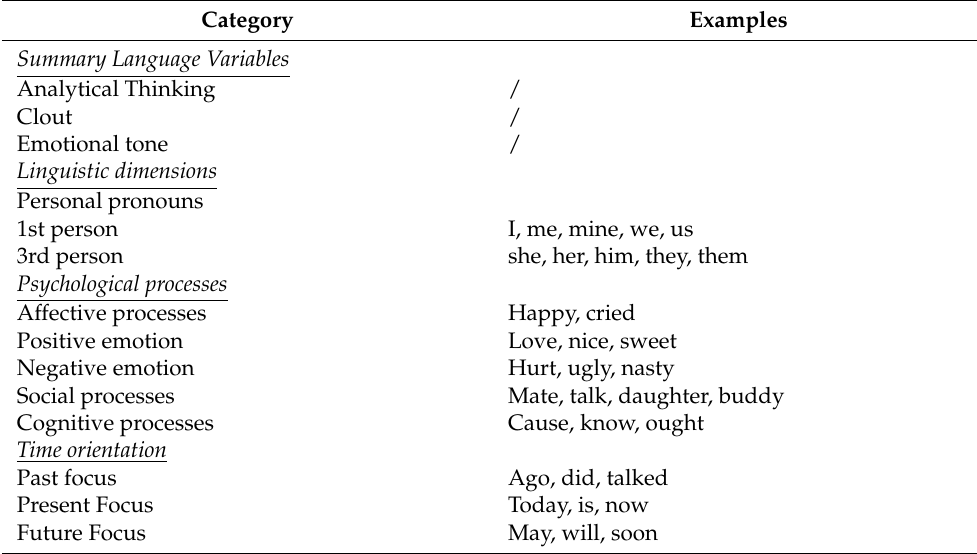
Table 1. LIWC categories used in this study. Adapted from Pennebaker JW, Boyd RL, Jordan K., and Blackburn K.